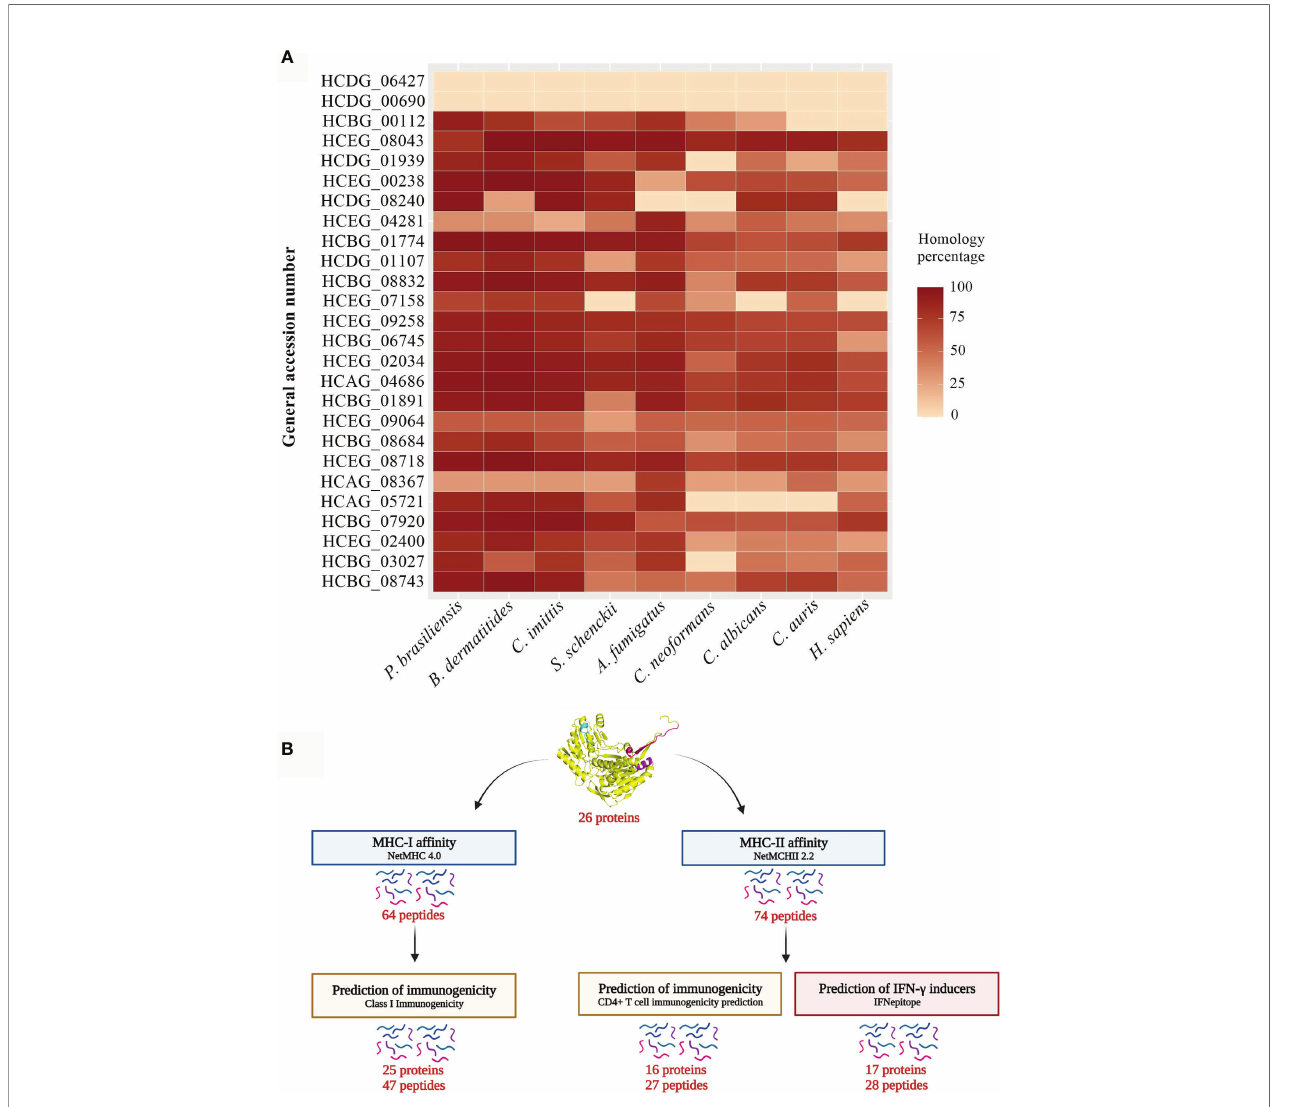
FIGURE 4 | Heat map and bioinformatics analysis fl owchart. (A) Heat map of the similarity percentage of 26 H. capsulatum antigenic proteins against P. brasiliensis , B. dermatitidis , C. immitis , S. schenckii , A. fumigatus , C. neoformans , C. albicans , C. auris and H. sapiens and bioinformatics analysis fl owchart. The analysis was performed by BLAST-p algorithm and ClustalX 2.1 software and the map plotted using software R package ggplot. (B) (I) Prediction of ligands to MHC-I was performed using NetMHC 4.0 server from the sequences of the 26 antigenic proteins previously described. (II) The NetMHCII 2.2 Server was used to predict MHC-II ligands, including the peptide sequences obtained by immunoprecipitation and that had low or no identity to human protein. (III) The Class I Immunogenicity software was used to predict the immunogenicity of the class I peptide MHC complex. (IV) The prediction of immunogenicity for MHC-II was performed by CD4 + T cell immunogenicity prediction server. (V) The IFNepitope server was used to predict IFN- g induction by MHC-II binding peptides. HCDG_06427: Uncharacterized protein, HCDG_00690: Mitochondrial thiamine pyrophosphate carrier 1, HCBG_00112: Sm domain-containing protein, HCEG_08043: Ribosomal protein S23, HCDG_01939: Ribosomal protein L14, HCEG_00238: 60S ribosomal protein L27, HCDG_08240: 60S ribosomal protein L2, HCEG_04281: 60S ribosomal protein, HCBG_01774: 40S ribosomal protein S15, HCDG_01107: Peroxidase, HCBG_08832: HSP-60 like protein, HCEG_07158: H15 domain-containing protein, HCEG_09258: Glyceraldehyde-3-phosphate dehydrogenase, HCBG_06745: Fructose-bisphosphate aldolase, HCEG_02034: Enolase, HCAG_04686: ATP-dependent molecular chaperone HSC82, HCBG_01891: ATP synthase subunit alpha, HCEG_09064: Citrate synthase, HCBG_08684: Elongation factor 1-gamma, HCEG_08718: 6-Phosphogluconate dehydrogenase,